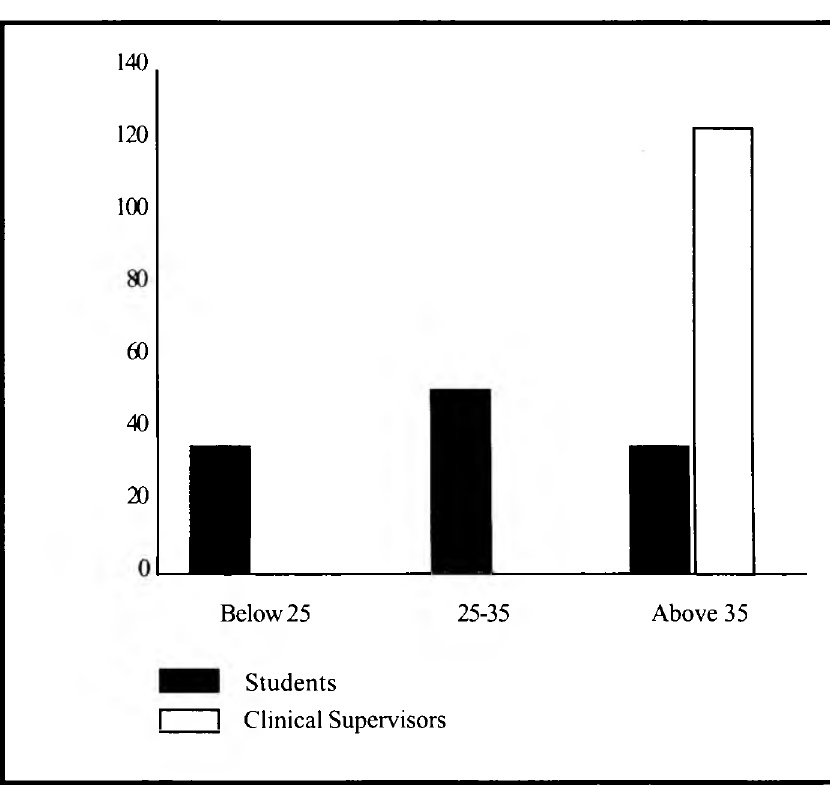
Figure 2: Ages of students versus the ages of clinical supervisors